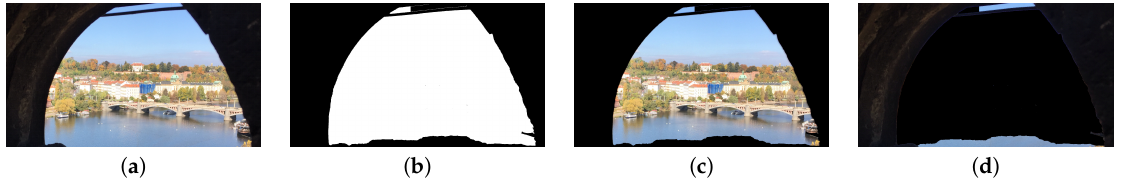
Figure 16. ( a ) Original image. ( b ) The GrabCut mask. ( c ) The obtained background using GrabCut. ( d ) The resulting frame-within-a-frame